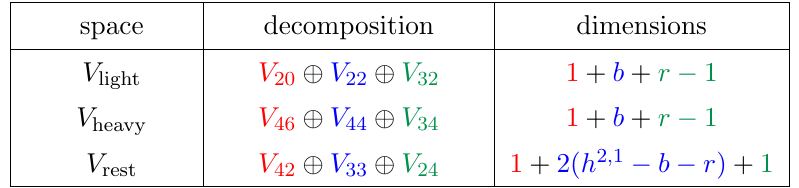
Table 5 . Decomposition of H 3 ( Y 3 ; R ) for II b ! IV d